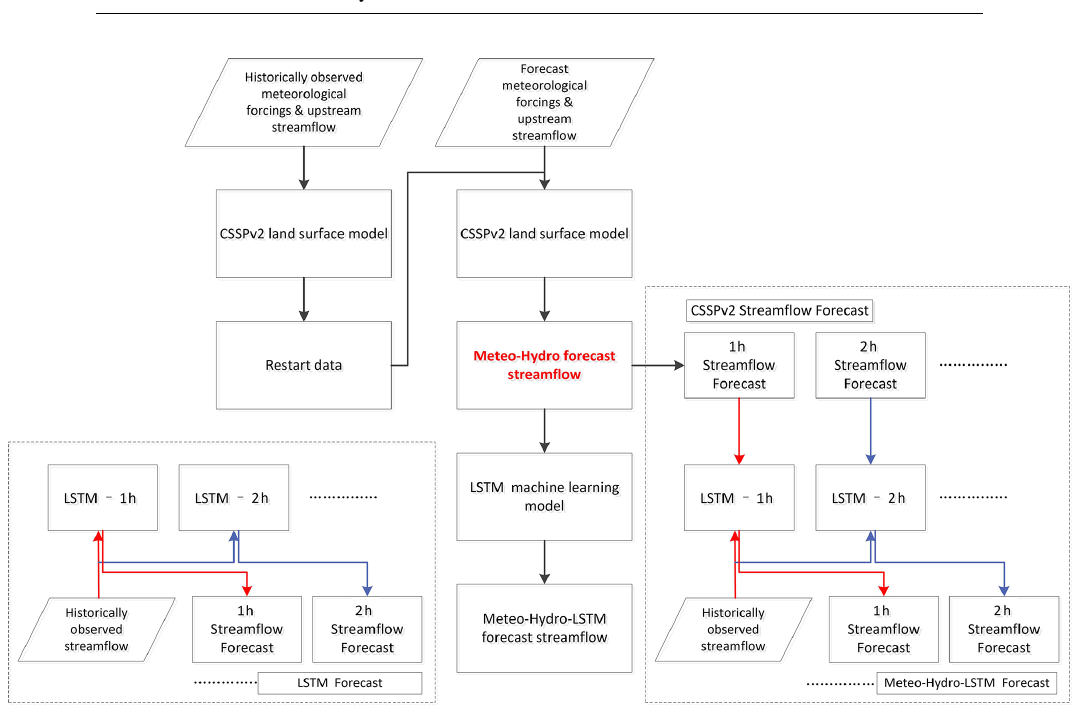
Figure 2. A diagram for the integrated hydrometeorological and machine learning streamflow prediction.